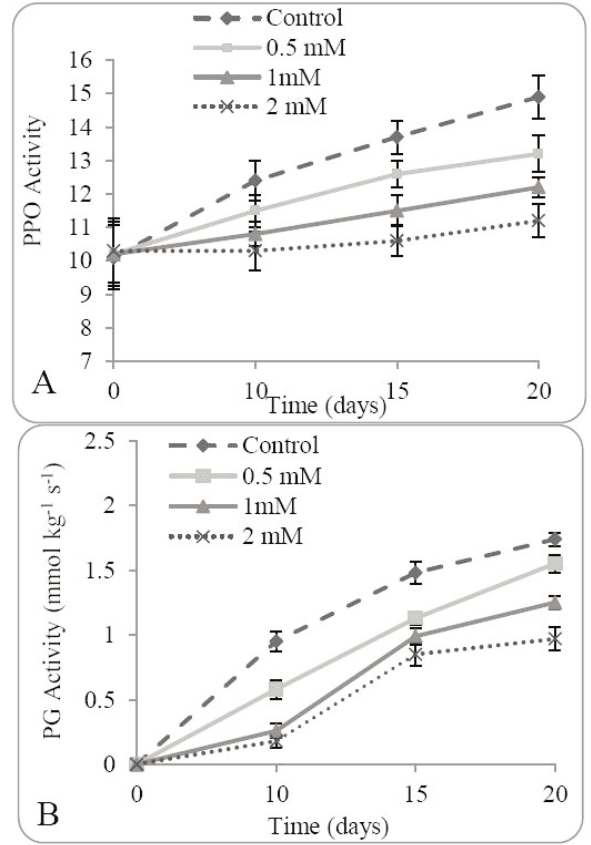
Fig. 5 - The effect of putrescine at different concentrations (0.5, 1 and 2 mM) PPO (A) and PG (B) activities of Musa acuminata L. during